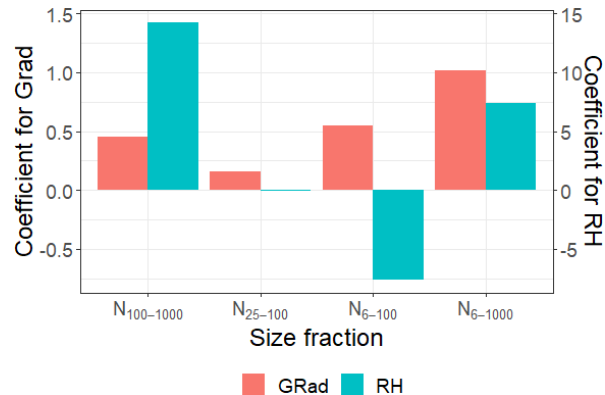
Figure 6. Coefficients (which are proportional to the partial effects) for global radiation (GRad) and relative humidity (RH) separately in the diameter ranges from 100 to 1000nm ( N 100 − 1000 ), from 25 to 100nm ( N 25 − 100 ), from 6 to 100nm ( N 6 − 100 ) and from 6 to 1000nm ( N 6 − 1000